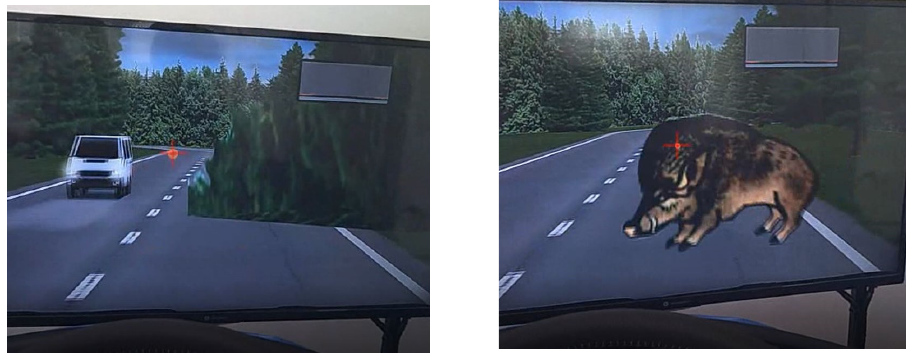
Figure 10. Examples of obstacles and view of the eye tracker. Source: own collaboration.